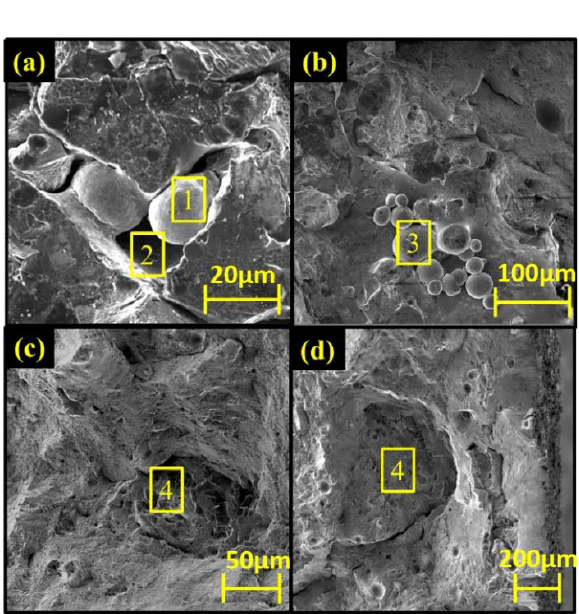
Figure 18: SEM fractography of sample 20A (as-printed L-PBF); (a, b): Un-melted powder particles (Label 1 & 3), unfilled zone (label 2); (c) & (d) brittle Laves zones (label